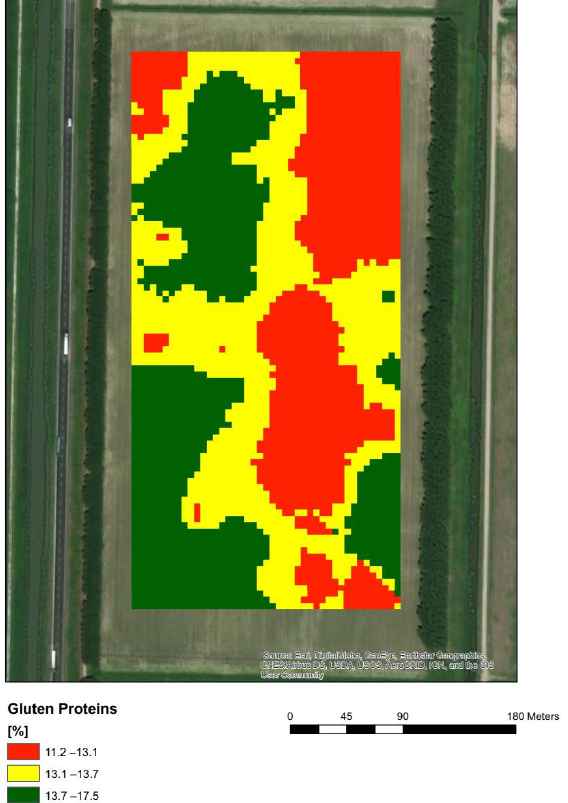
Figure 1. Map of total protein content distribution in the field according to the data of gluten protein extractions.